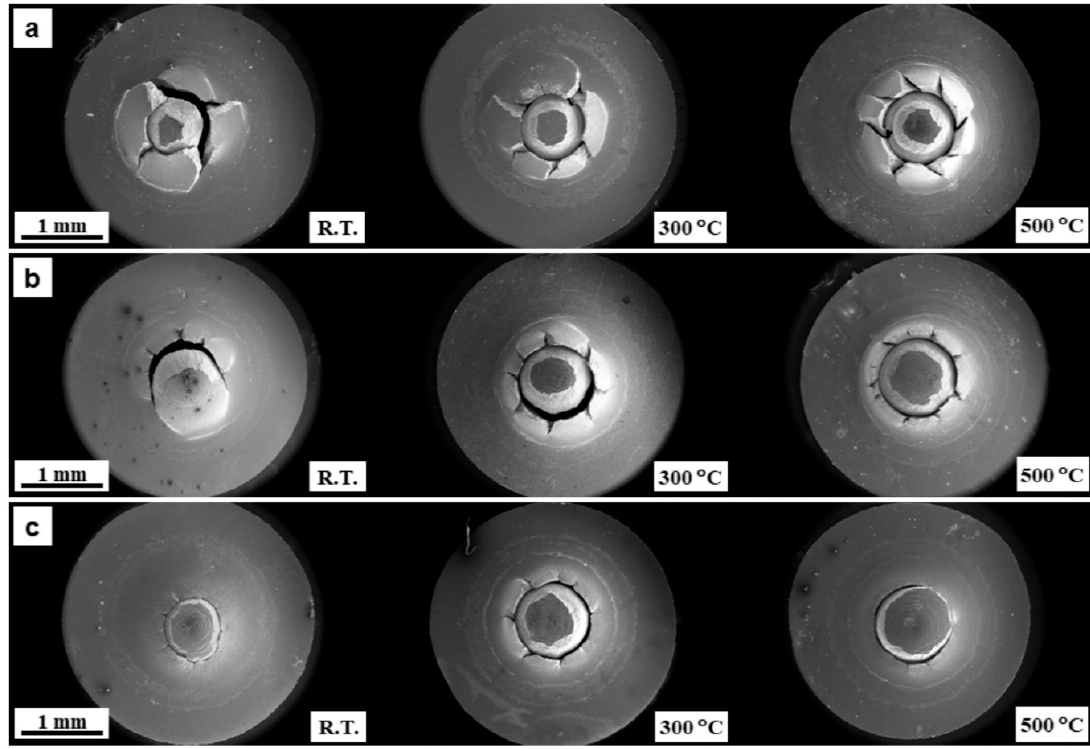
Figure 8. SEM images of small punch specimens after the fracture at R.T., 300 and 500 ◦ C: ( a ) ODS-NoZr, ( b ) ODS-0.45Zr, ( c ) ODS-0.60Zr.